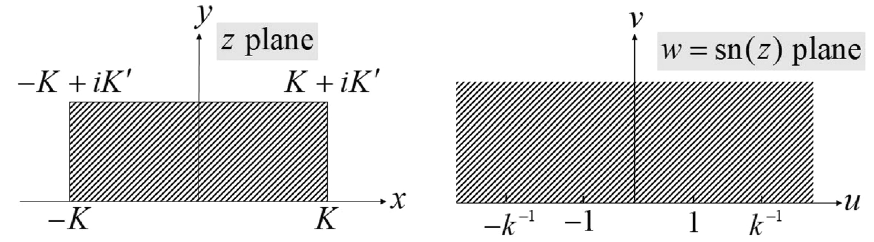
Figure 2. Schematic of the conformal mapping from a rectangle in the z -plane to the upper half of the w -plane 41 .